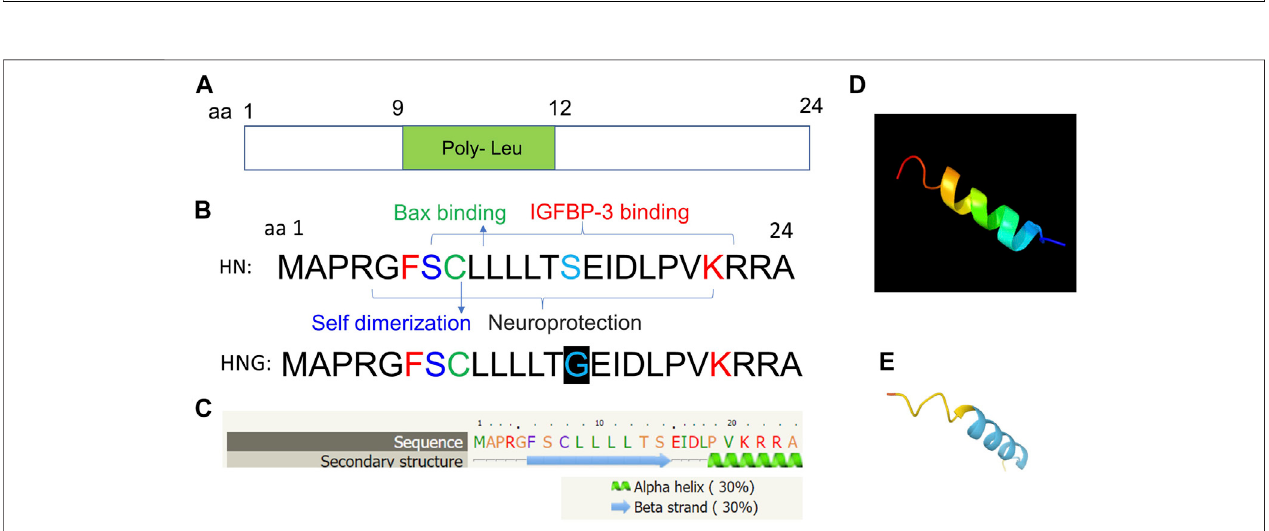
FIGURE 3 | Predicted molecular structural analyses of HN. (A) HN is a small peptide of 24 amino acid residue and is comprised of a poly-leu motif (amino acid residues 9 – 12). (B) Key residues for BAX binding (amino acid residue 8), IGFBP3 binding (amino acid residues 6 – 21), and self-dimerization (amino acid residue 7) are shown.ThefullsequenceofHNanditsanalogueHNG(S14G)withsubstitutionofserineataminoacidresidue14toglycineareshown. (C) Secondarystructurepredicts characteristics of a beta-sheet domains (amino acid residues 6 – 14) and an alpha-helix (amino acid residues 19 – 24) based on bioinformatic analysis. (D, E) 3D structure analyses are performed using the Phyre2 and (http://www.sbg.bio.ic.ac.uk/phyre2/) (D) , and AlphaFold web portals (https://alphafold.ebi.ac.uk/) (E) .